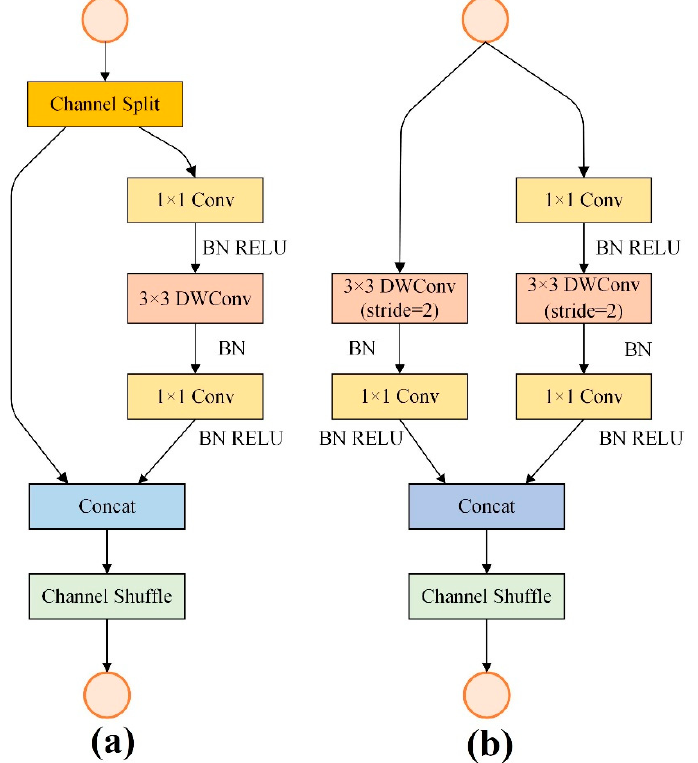
Figure 3. Standard Shuffle unit ( a ); Shuffle unit for down-sampling ( b ) Reprinted/adapted with permission from Ref. [49]. 2018, ©Springer Nature.